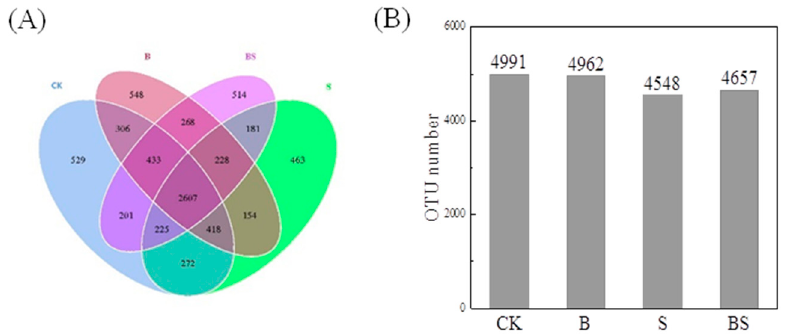
Figure 3. Venn diagram ( A ) based on shared and unique operational taxonomic units (OTUs) between different treatments and OTU number ( B ) of different treatments. CK: organic substitution; B: organic substitution + biochar; S: CK + NaCl; BS: B + NaCl.